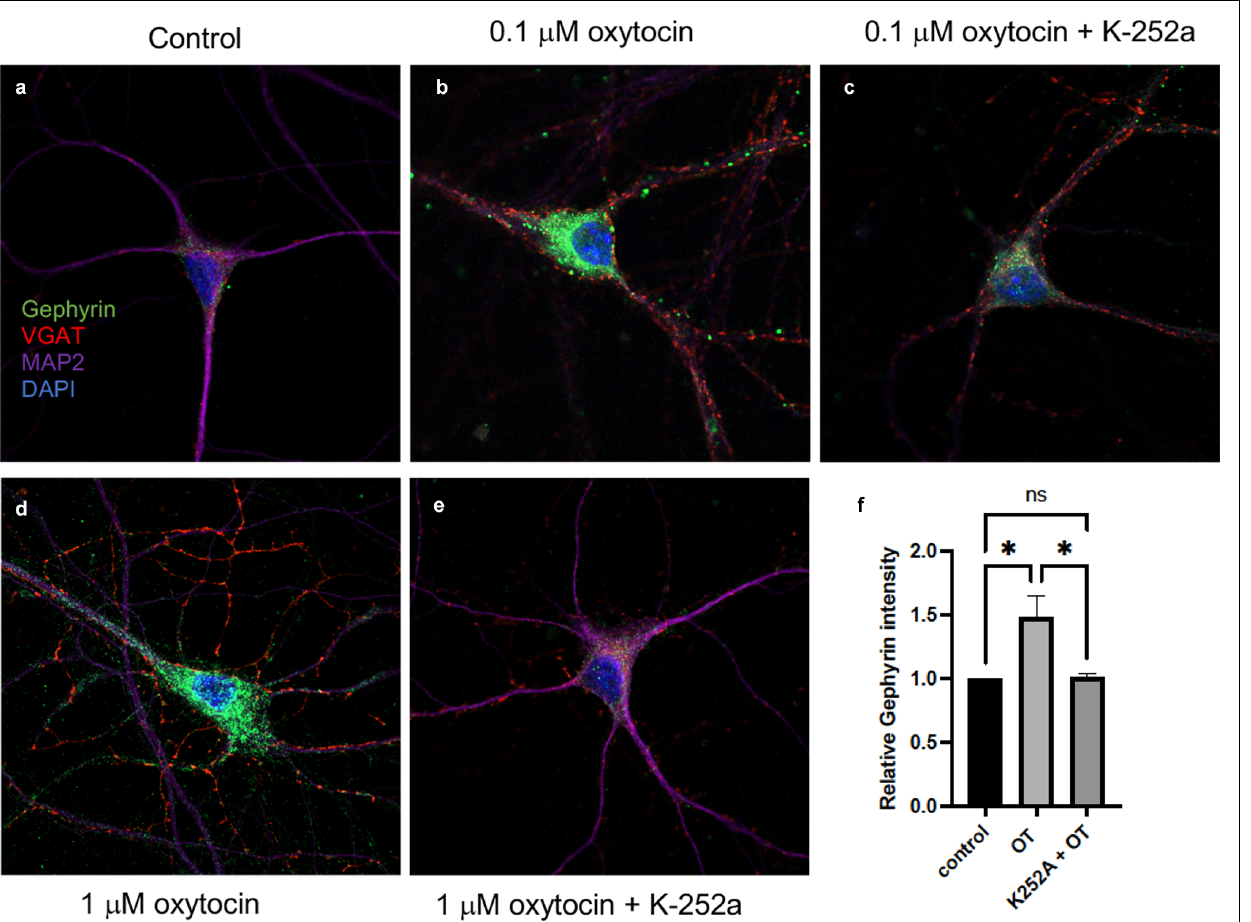
FIGURE 6 | Oxytocin increased gephyrin clustering in primary cortical neurons (DIV7). Immunostaining of Gephyrin (green; Abcam ab25784), VGAT (red; Synaptic Systems 131011), MAP2 (Covance PCK554050), DAPI (blue) immunoreactivity was detected in primary cortical neurons. (A) Image of staining of control cells. No treatment. Scale, 10 µ m. (B) Image of 0.1 µ M oxytocin-treated cells for 2 h. Scale, 10 µ m. (C) 0.1 µ M oxytocin plus K252a (200 ng/ml). (D) 1 µ M oxytocin (2 h). Scale, 10 µ m. (E) 1 µ M oxytocin pretreated with 200 ng/ml K252a (2 h). (F) Summary plot of gephyrin fluorescence over the same size region of the cell body in response to oxytocin (OT). Three independent experiments were carried out with analysis of at least 50 cells across conditions for each experiment. The images were collected with matching laser intensities and detector response and subjected to ANOVA. All p values were determined by one-way ANOVA with